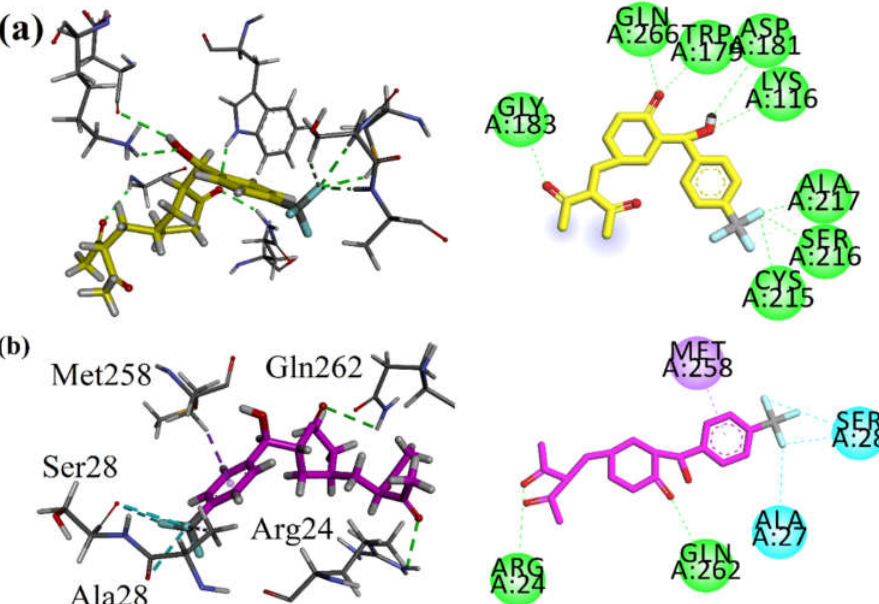
Figure 3. 3-D/2-D interaction plot of ( a ) major ( S , S , R - 5 , as yellow stick model) and; ( b ) minor ( S , S , R - 5 , as pink stick model) diastereosomers into the binding site of homology modeled α-amylase.